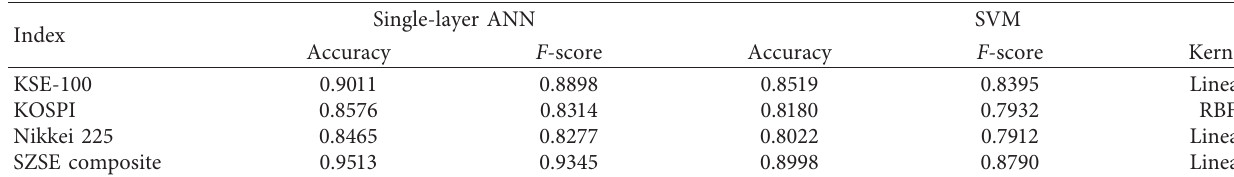
Table 12: Prediction performance of ANN and SVM